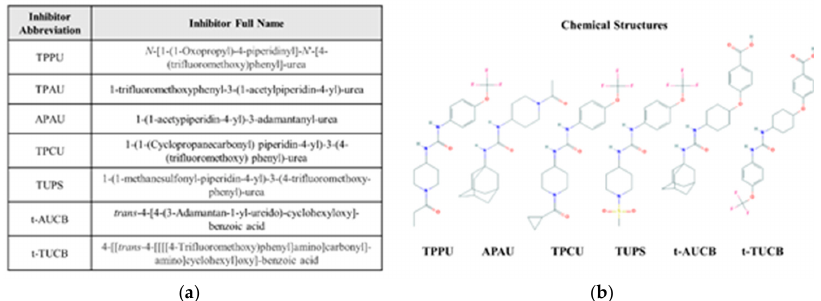
Figure 2. Commonly used soluble epoxide hydrolase inhibitors. ( a ) Abbreviations and full chemical names for commonly used inhibitors. ( b ) Chemical structures for representative inhibitors. Chemical structures were downloaded from the public PubChem database (pubchem.ncbi.nlm.nih.gov).